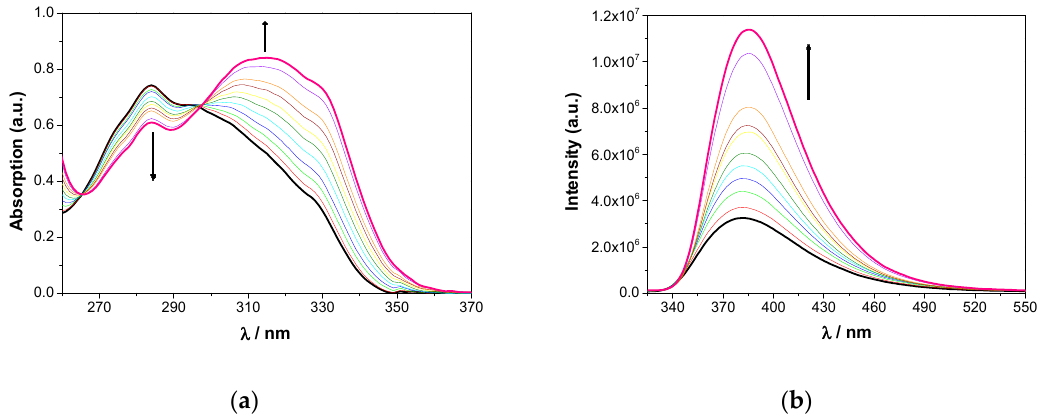
Figure 4. Changes in the UV ( a ) and emission ( b ) spectra of Naph-urea 5a (5.0 × 10 − 5 M) upon addition of TBA F (up to 10 equiv.) in CH 2 Cl 2 . The arrows indicate the decreasing or increasing amounts of salt.